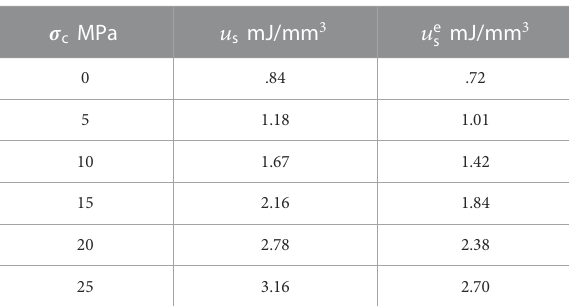
TABLE 2 Static load energy and static elastic energy under different con fi ning